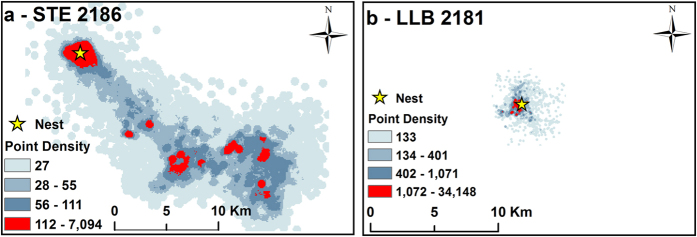
Point density analysis (smoothing factor of 500 m) of all movement data from one STE (#2186 a) and one LLB (#2181 b) during the entire breeding season.Note that the total area of STE’s movements was greater than LLB’s. In addition, STEs use “flight corridors”, of ~5–30 km, from their nests to their main foraging areas (a), while LLBs tended to forage close to their nests (b). These figures were generated by using GIS software - ArcGIS (ESRI. 10.1).